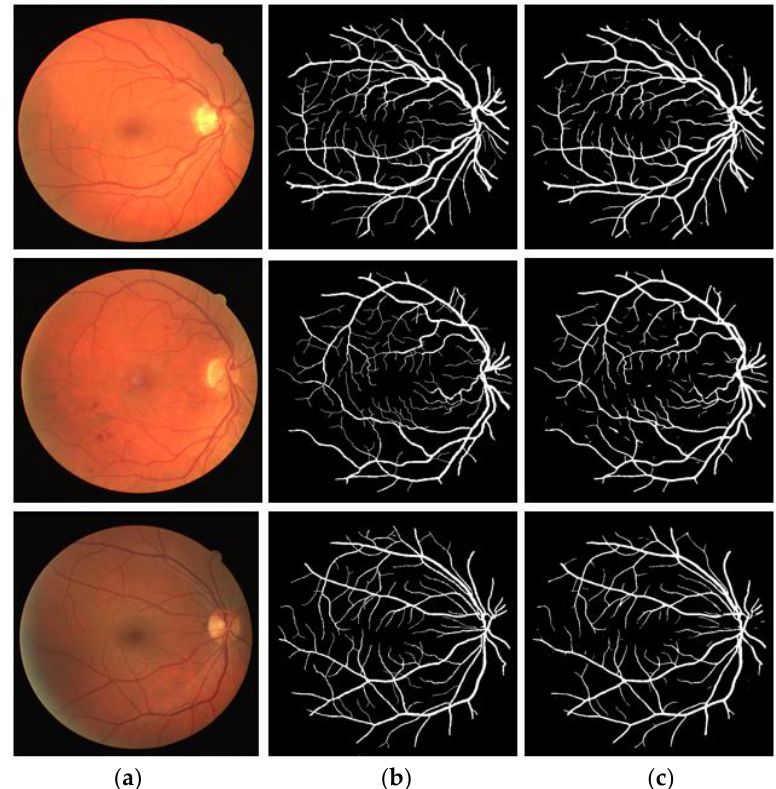
Figure 7. VSUL-Net visual results for the DRIVE dataset: ( a ) original fundus image, ( b ) expert annotation, and ( c ) VSUL-Net predicted mask.